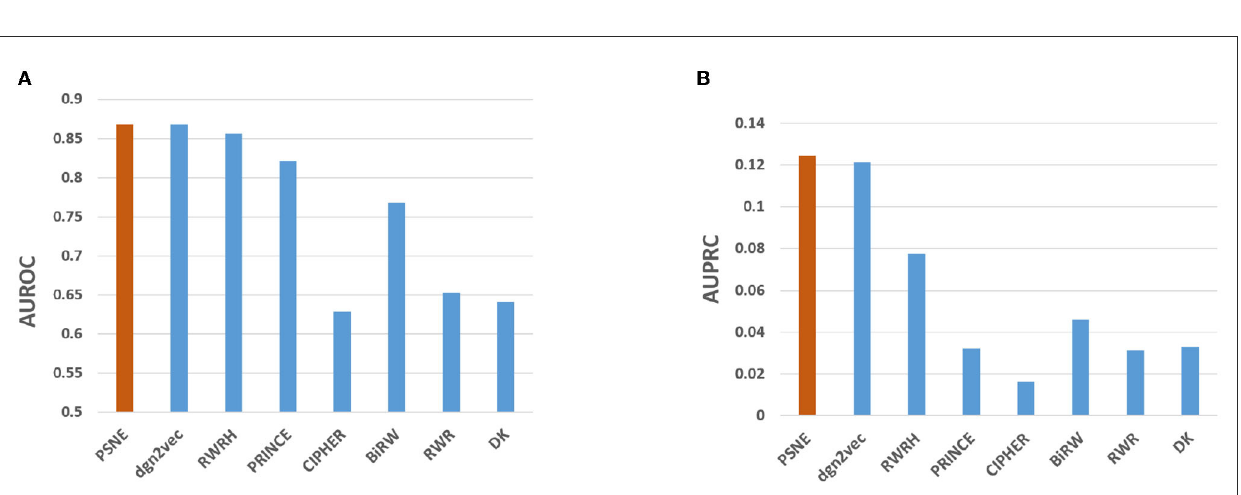
FIGURE2 Performance evaluation of PSNE in terms of (A) AUROC and (B) AUPRC, with comparison to the state-of-the-art methods.